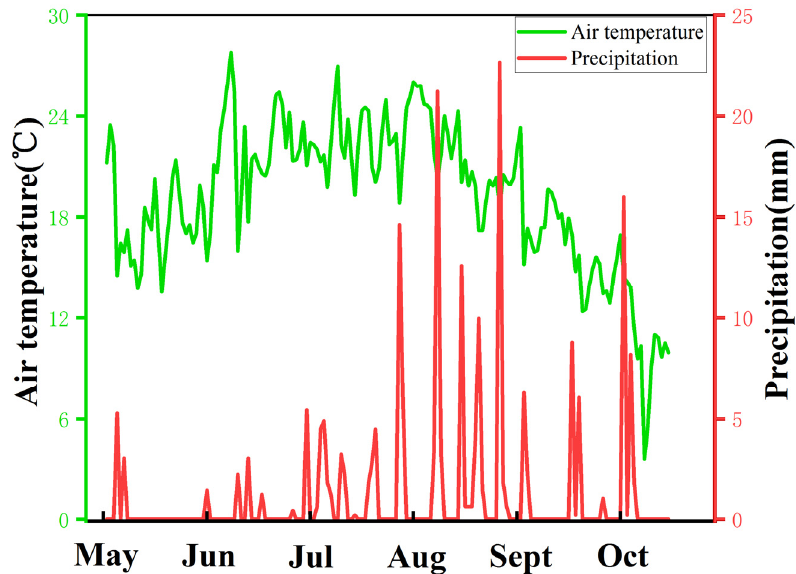
Figure 1. Meteorological data of sorghum growing